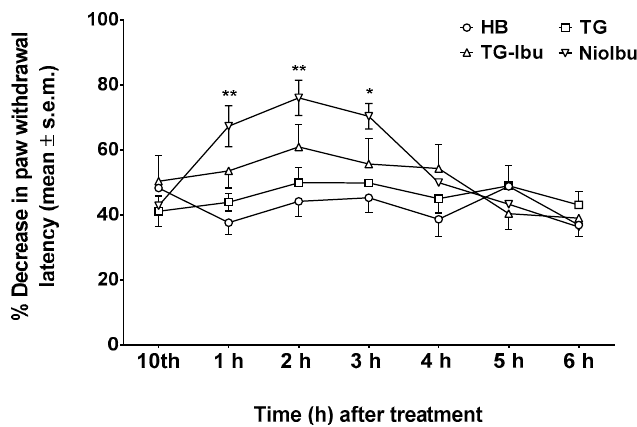
Figure 6. Effects of Hepes buffer (HB), the unstructured surfactant formulation (TG), the unstructured surfactant formulation with the same Ibuprofen (IBU) concentration (TG-Ibu), and TW20-Gly loaded with IBU (NioIbu) on allodynia induced by a chronic constriction injury of the right sciatic nerve. * is for P < 0.05 and ** is for P < 0.01 versus TG. N = 8.